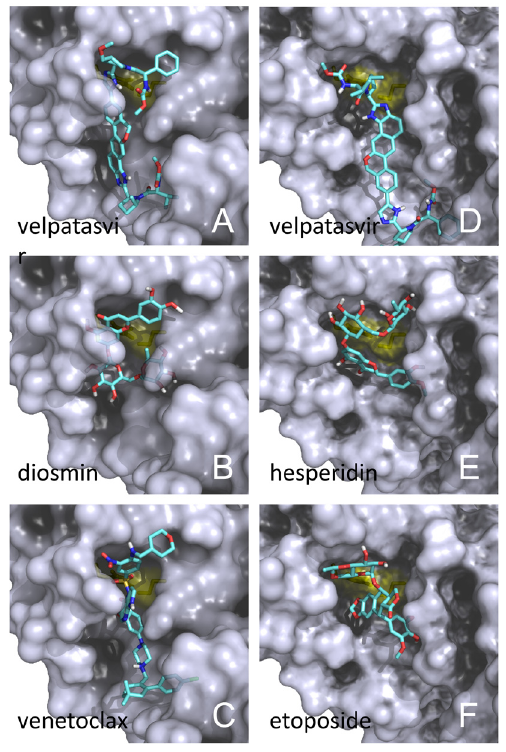
Figure 1. Virtual screening results for the SARS-CoV-2 3CL pro protease. Docking of representative drugs into the active sites of A chain ( A , B , C ) and that of B chain ( D , E , F ). The catalytic residue surfaces are coloured in yellow. Atom colours of drug: C: cyan; O: red; N: blue; H: white; S: yellow; only polar hydrogens are shown. Prepared with PyMOL.